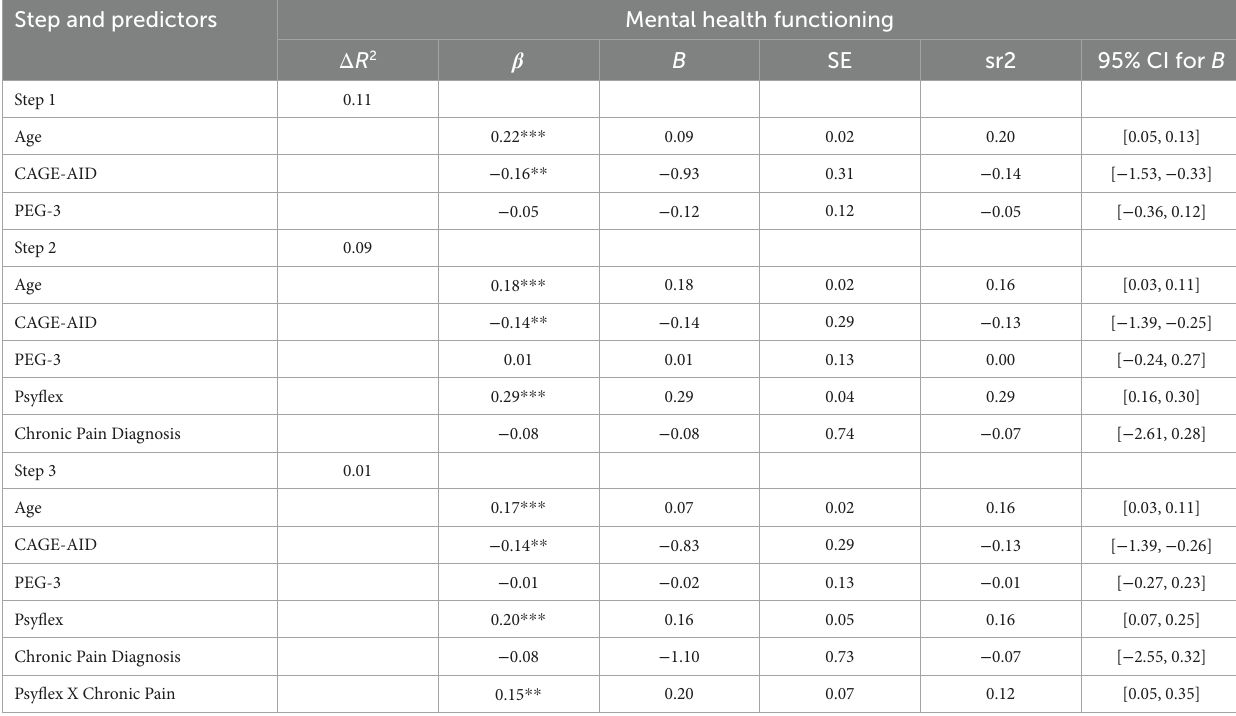
TABLE 3 Hierarchical multiple regression testing interaction model on mental health.